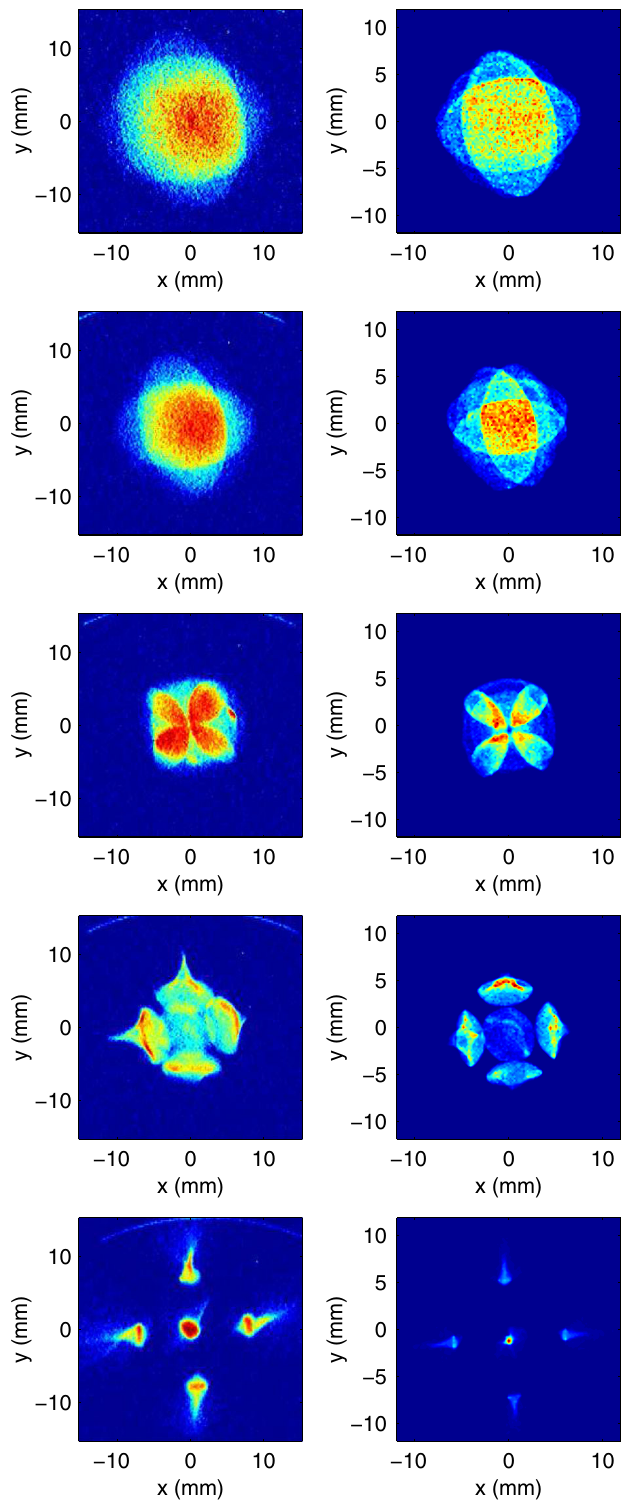
FIG. 5. (Color) False color images of the measured (left column) and simulated (right column) electron beam transverse density distribution at YAG1 location. The five rows respectively corre- spond to the different values of the magnetic field (from top row) ^ B ¼ 0 : 333 , 0.339, 0.350, 0.359, and 0.376